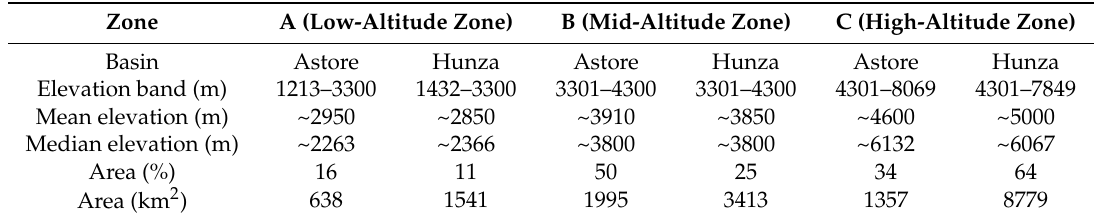
Table 1. Main features of the elevation zones extracted from the ASTER GDEM of the Astore River and Hunza River basins.